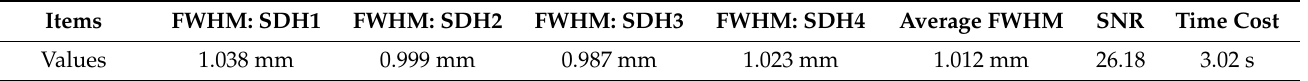
Figure 10. The experimental results for the SDHs in a two-layer structure. ( a ) The image reconstructed by the proposed method. ( b ) The normalized amplitudes of four SDHs. Table 5. FWHMs and time costs of the proposed method in experiment B.